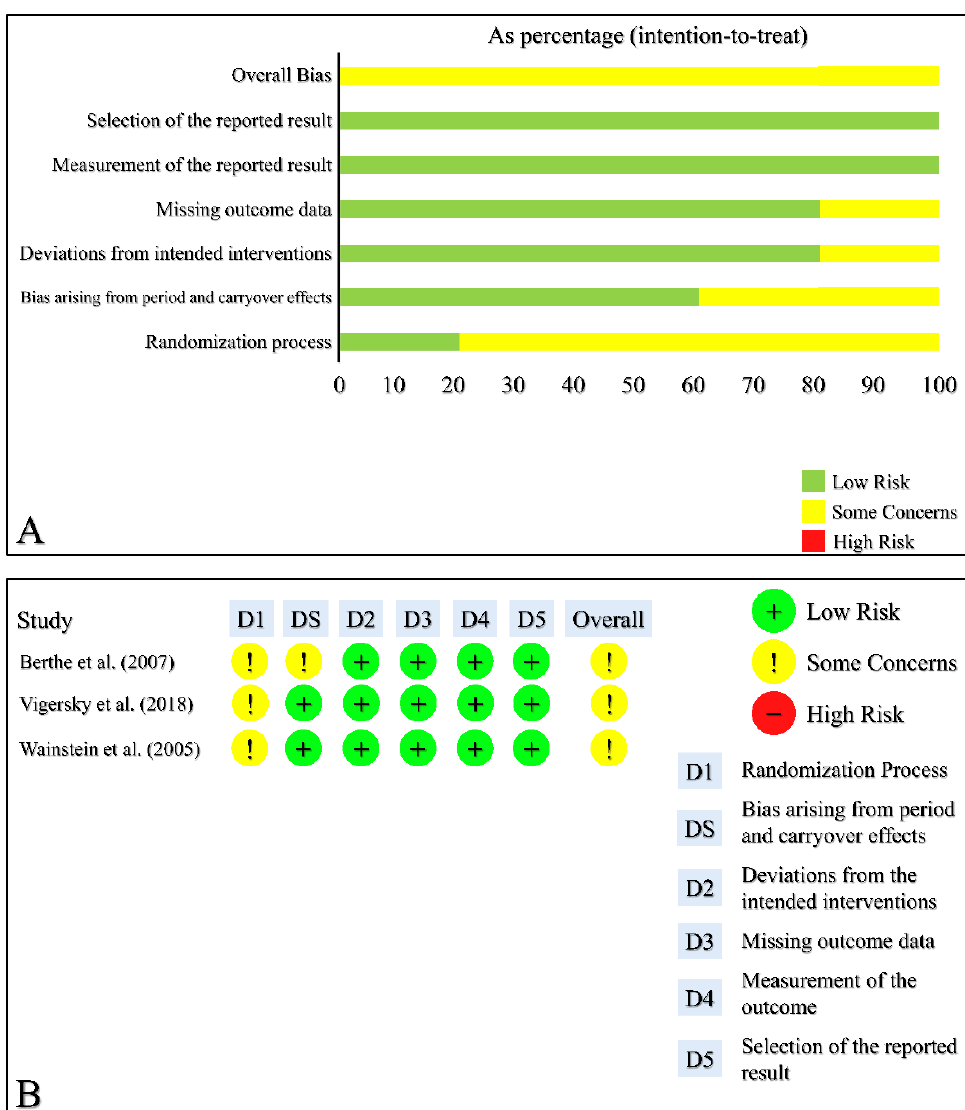
Figure 3. Risk of Bias Assessment Illustration as Percentage for Studies with Parallel Design ( A ), Risk of Bias Assessment Traffic Light Illustration for Studies with Crossover Design ( B ).